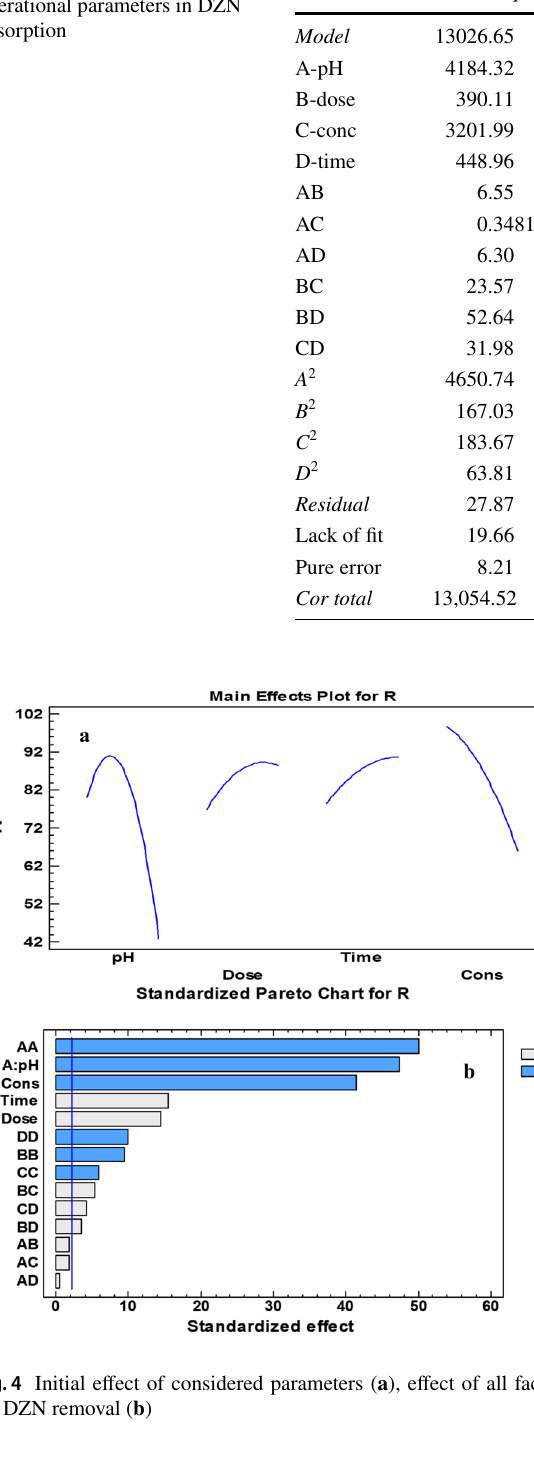
Table 3 Variance analysis of operational parameters in DZN adsorption